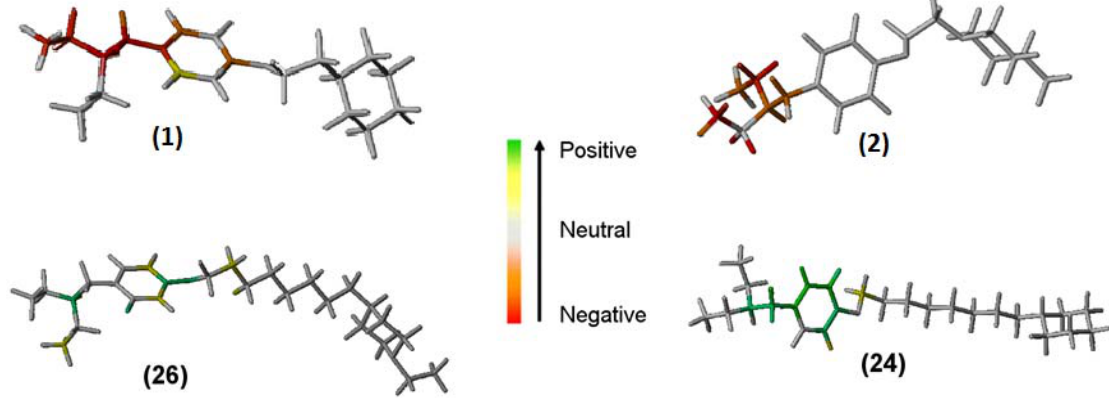
Figure 2. The HQSAR contribution maps of compounds 26 (most potent) and 1 (least potent) for the AChE inhibitory activity, and 24 (most potent) and 2 (least potent) for BChE inhibitory